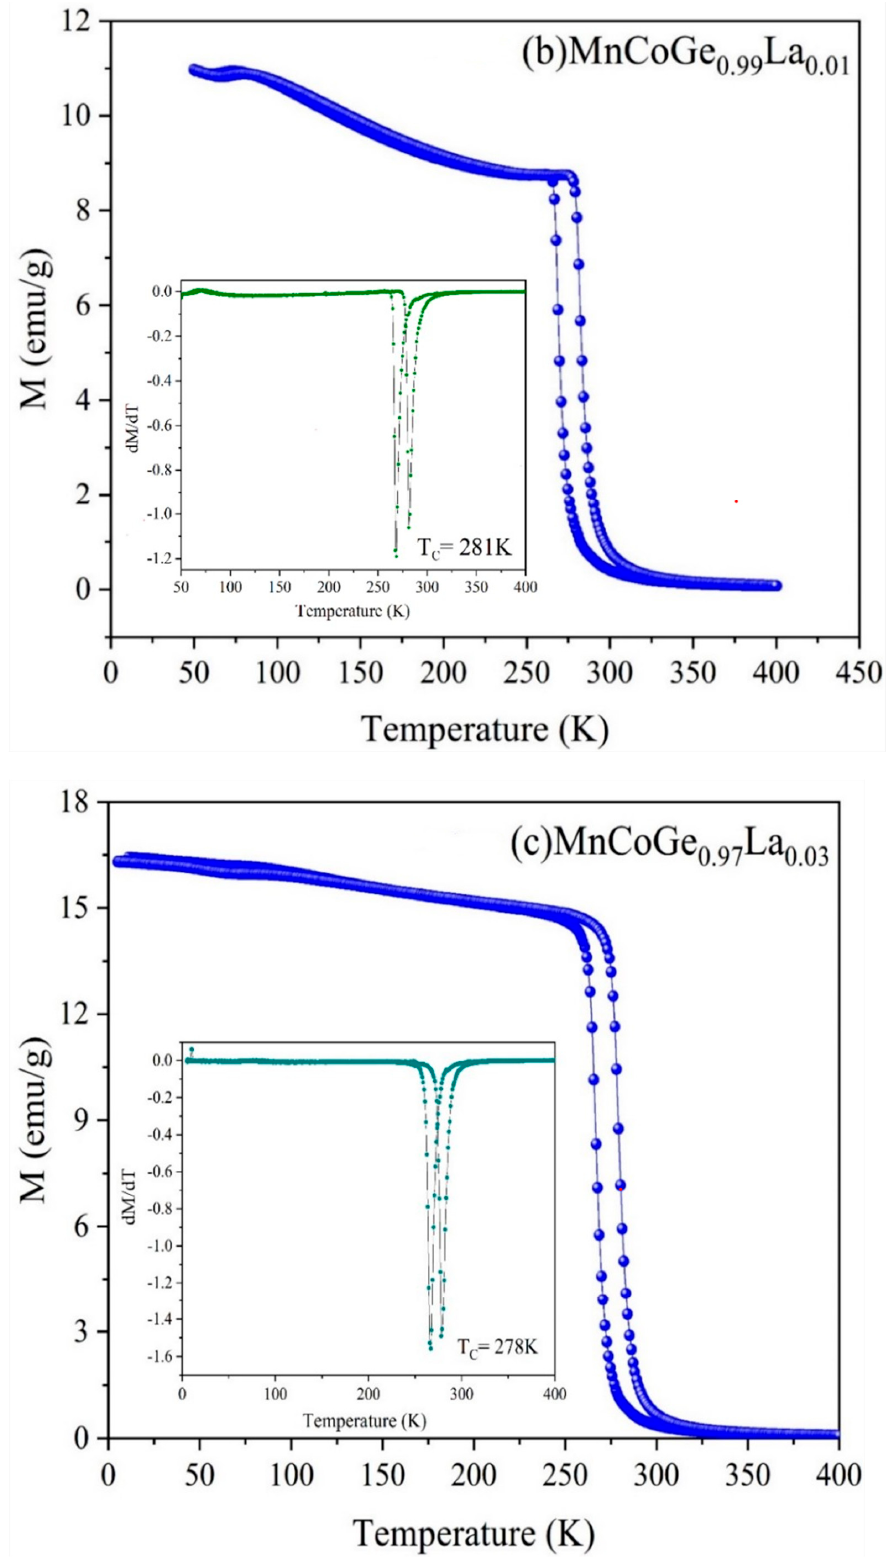
Figure 5. Temperature dependence of magnetization of ( a ) MnCoGe, ( b ) MnCoGe 0.99 La 0.01 , and ( c ) MnCoGe 0.97 La 0.03 measured under a magnetic field of 500